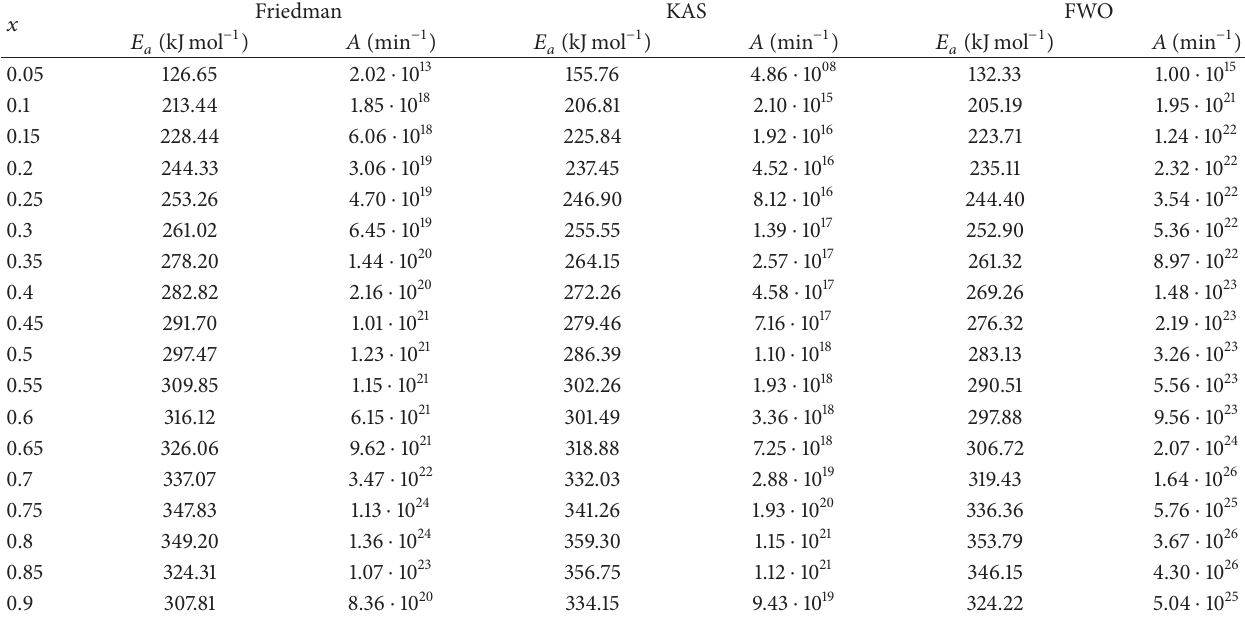
Table 2: Calculated kinetic parameters for a Canadian lignite coal by three different isoconversional methods. 𝑥